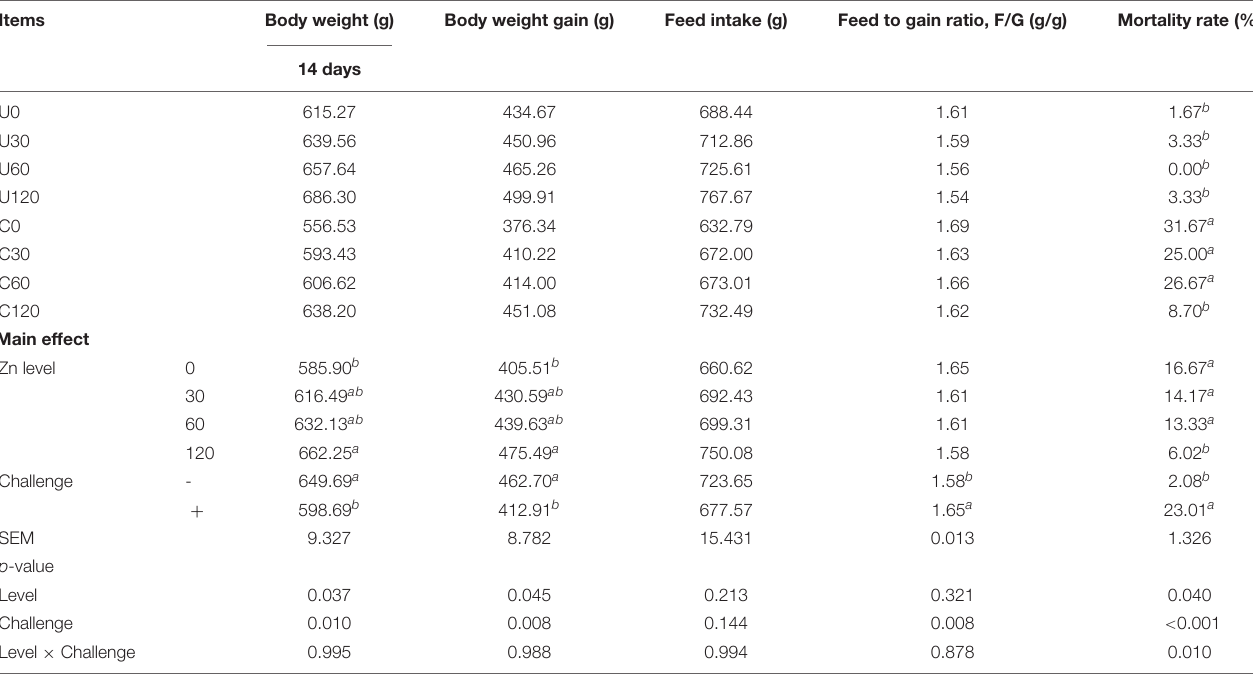
TABLE 5 | Effect of dietary Zn–Met levels on growth performance of duck challenged with APEC from 7 to 14 1